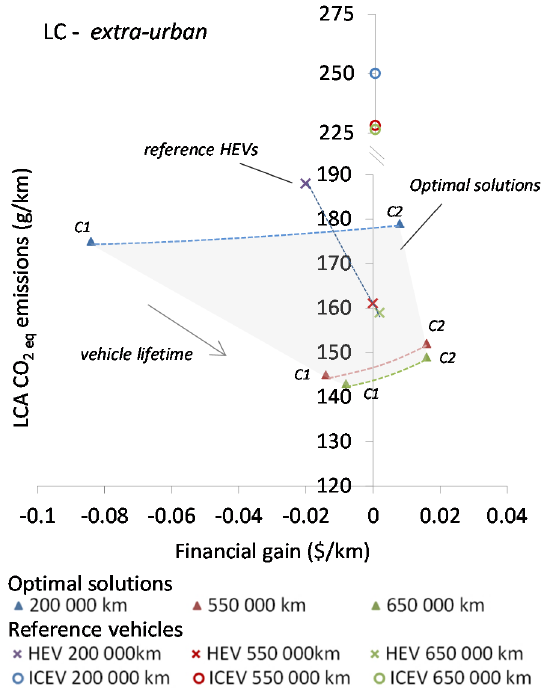
Figure 6. Set of Pareto solutions for multi-objective optimized HEVs concerning LC cycle and several life time distances, and comparison with the reference vehicles (ICEV and HEV). Table 8. Main characteristics of the optimized taxi.